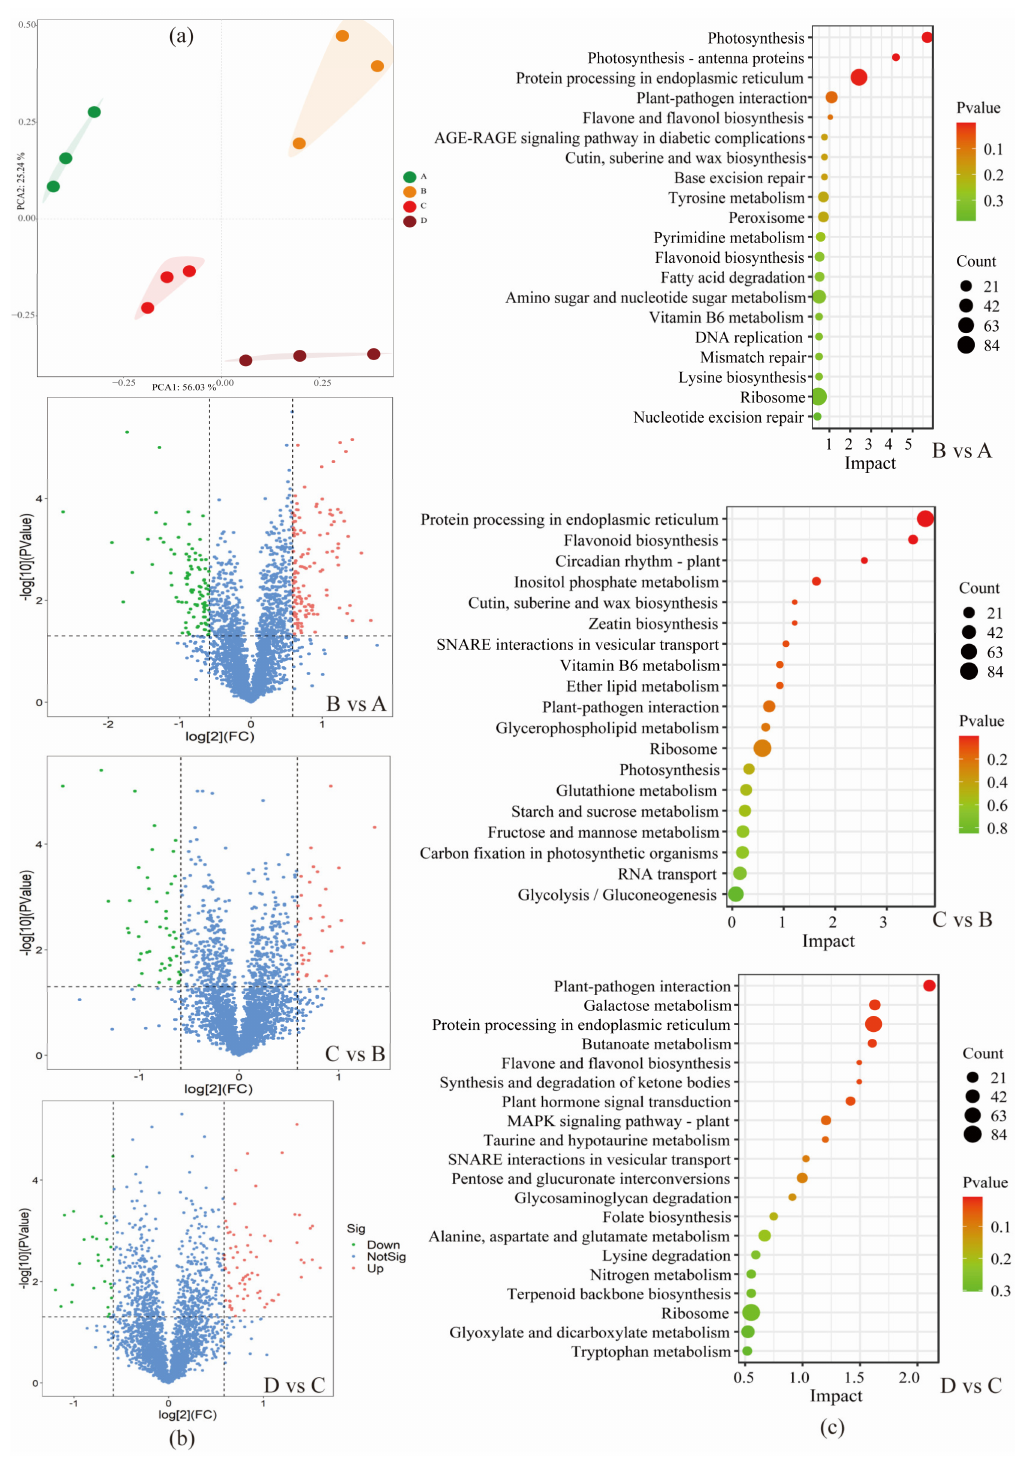
Figure 3. Results of proteomics overview analysis. PCA score of four coffee sample groups ( a ). Volcanic map analysis of DEPs. Red: up-regulation; green: down-regulation; blue: not significant. A total of 125, 34, and 71 proteins were up-regulated, while 98, 47, and 27 proteins were down- regulated ( b ). The enrichment analysis of the KEGG pathway in coffee at each maturation level and the top 20 pathways in each stage ( c